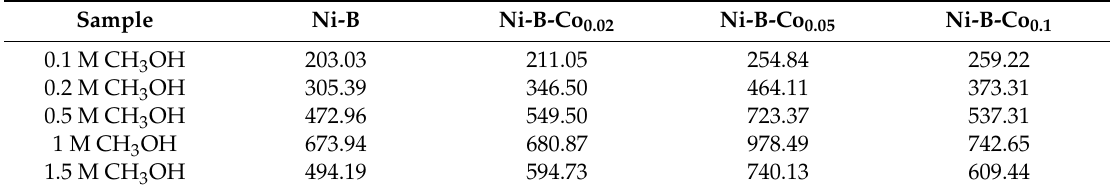
Table 2. The CH 3 OH oxidation peak currents (A g − 1 ) on Ni-B and Ni-B-Co nanoparticles.